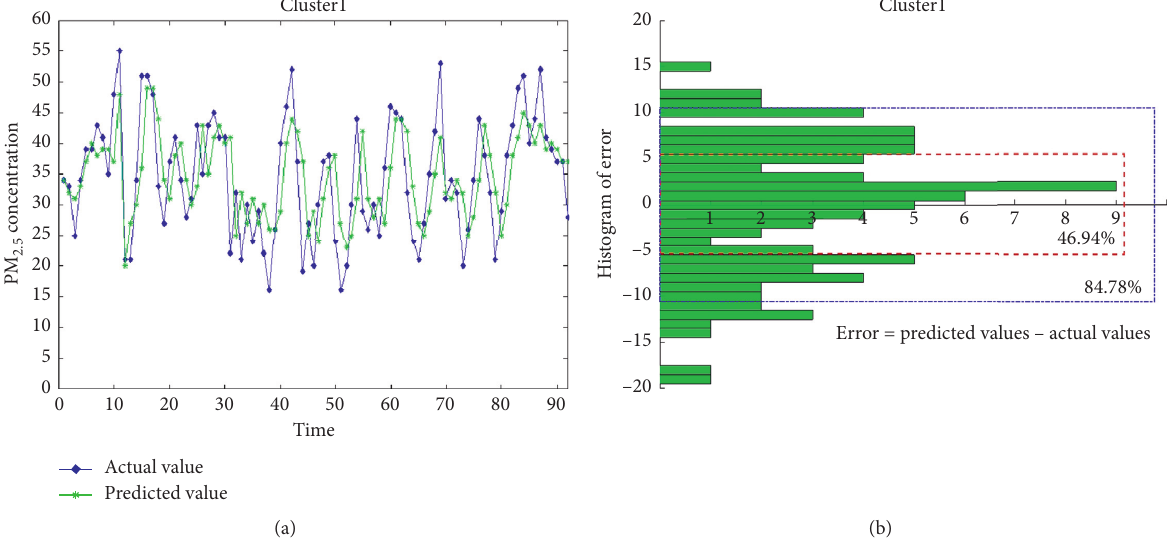
Figure 9: Histograms of the forecasting errors for the difference equation model, based on the experiments in the Bohai Rim Region of China. The red box indicates the amount of prediction error between 5 units. The blue box indicates the amount of prediction error between 10